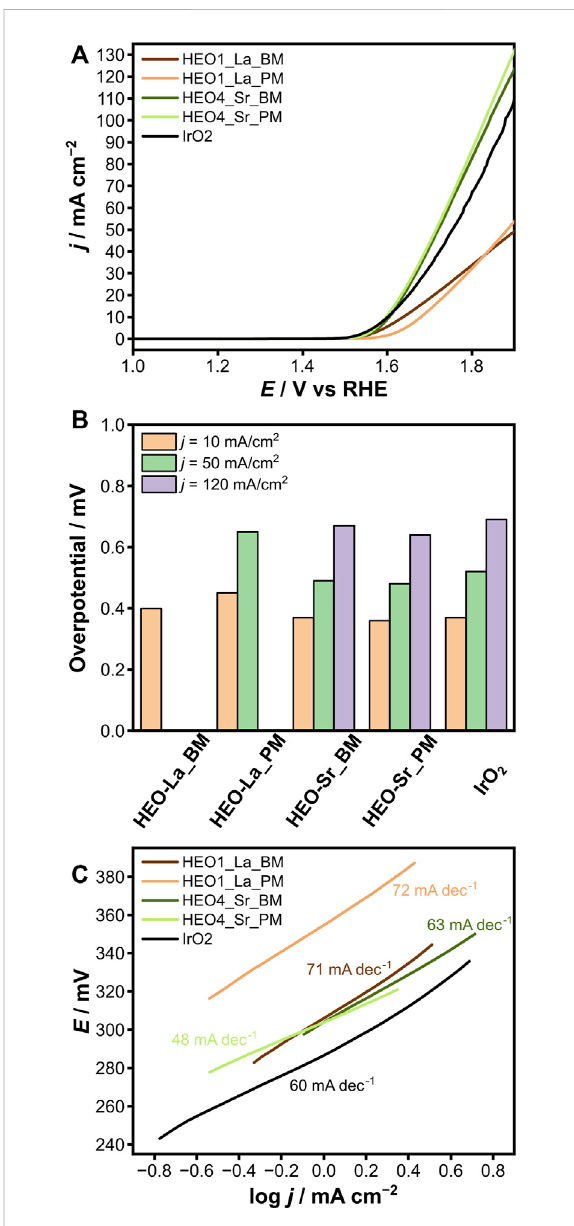
FIGURE 9 OER performance for HEO-La and HEO-Sr prepared using both ball milling (BM) and Pechini method (PM) (A) linear potential sweep voltammogram, (B) comparison of overpotential, (C) Tafel plot with the slope indicated. HEO-La_PM and HEO-Sr_PM were calcined at 1,200 ° C for 12 h in